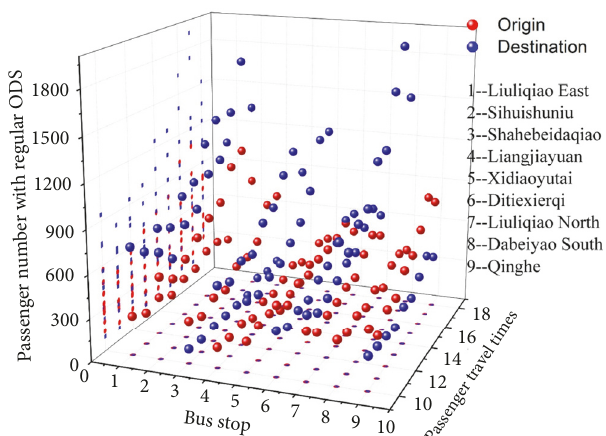
Figure 8: Five origin stops and five destination stops (X axis) with the largest passenger number with regular ODs (Z axis) in the morning for different travel times (Y axis).